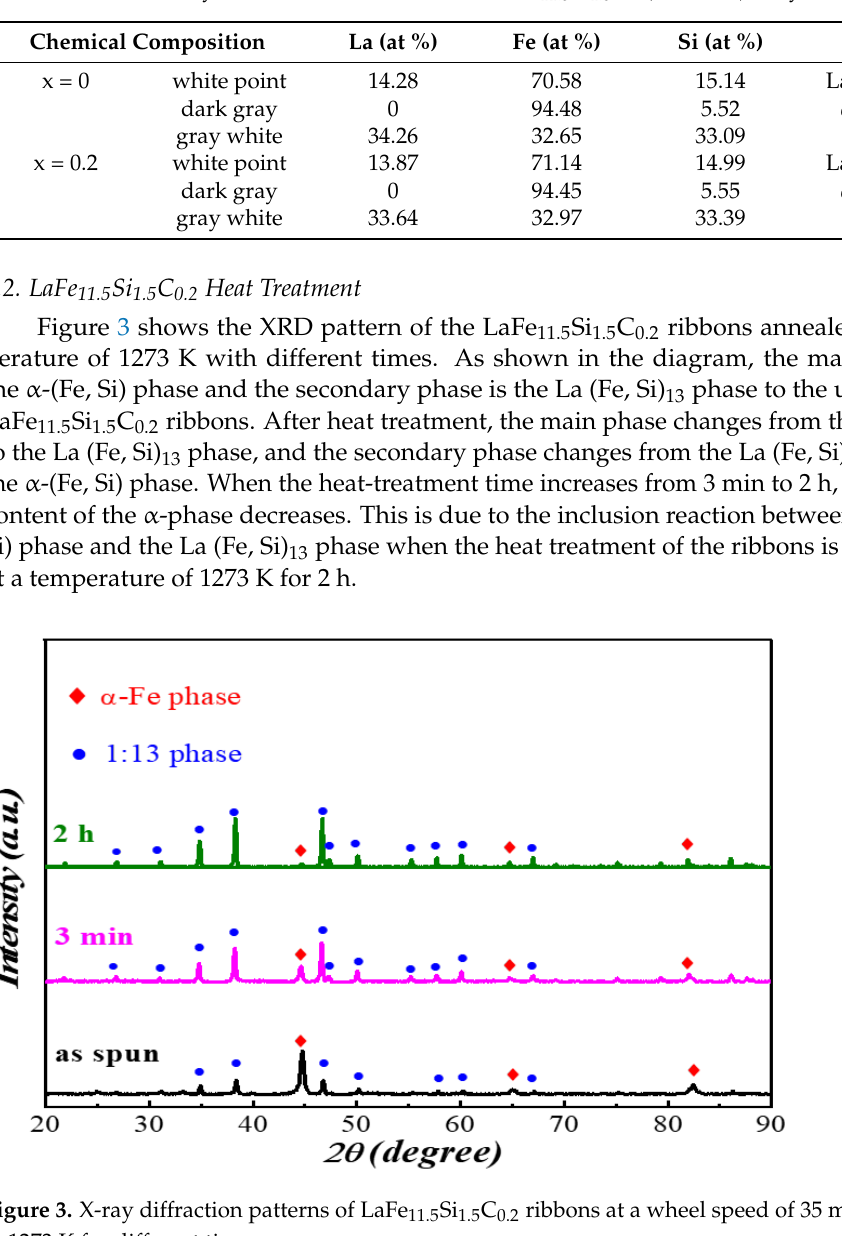
Table 2. The EDS analysis of the micro-structure of LaFe 11.5 Si 1.5 C x (x = 0, 0.2) alloys.